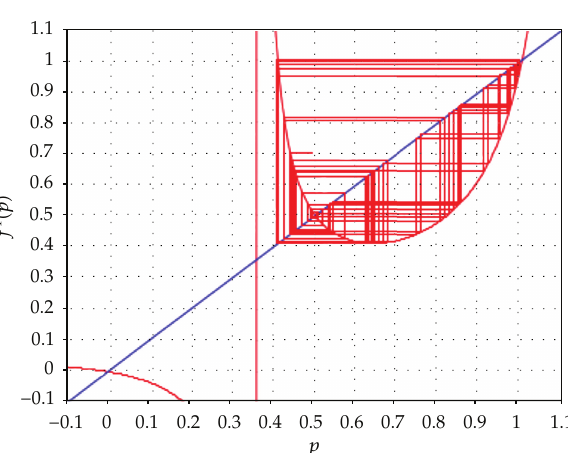
Figure 7: Grab the dollar game—phase